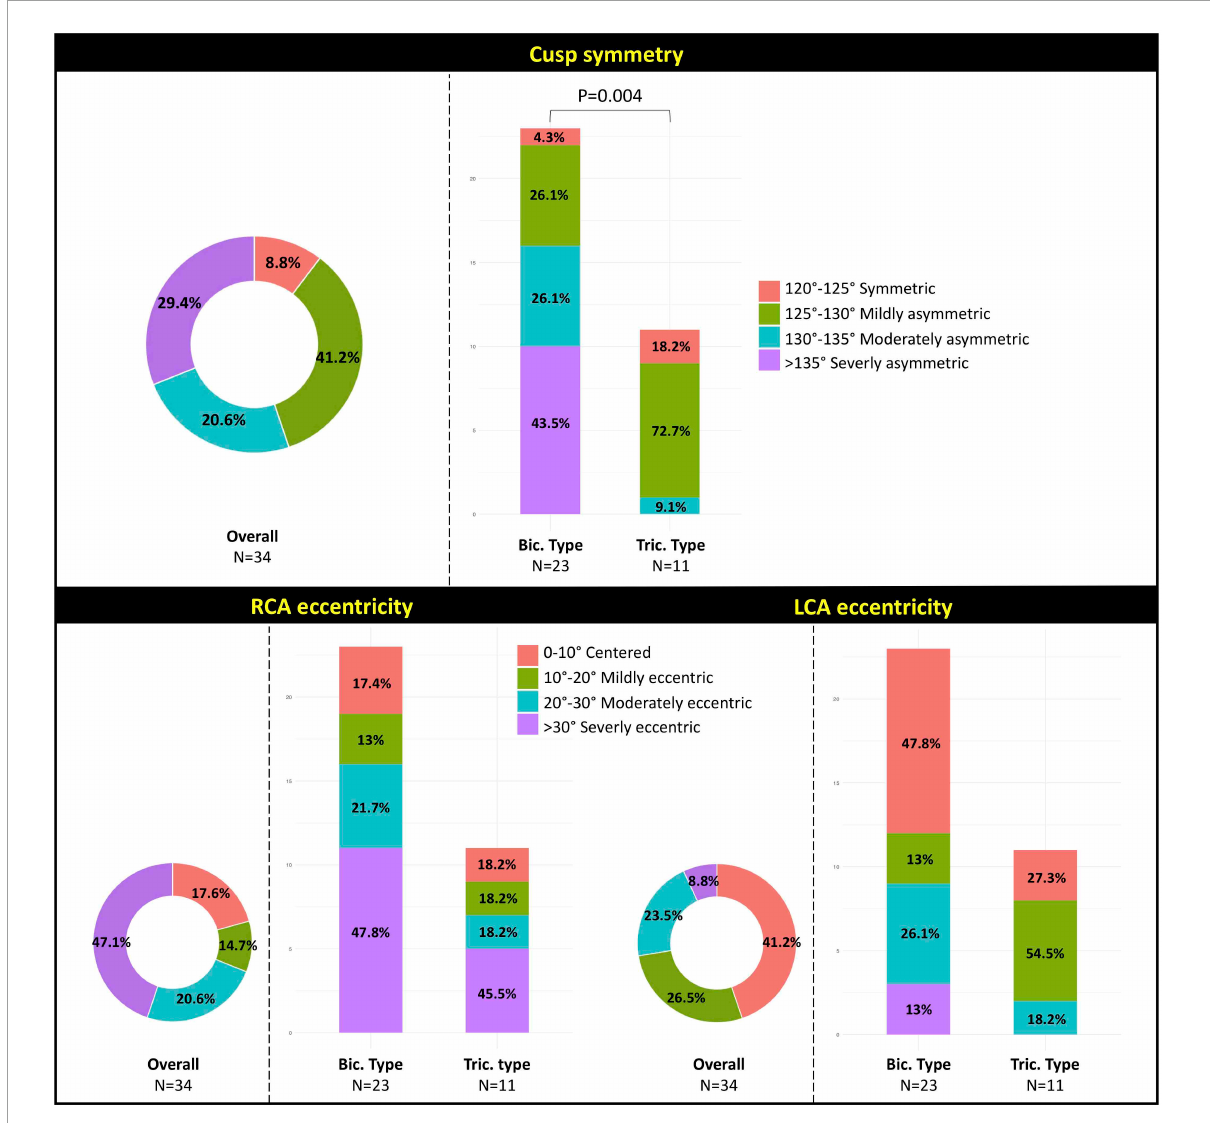
FIGURE3 Illustration of the degree of anatomical asymmetry in study’s BAV population: (top panel) cusp symmetry; (bottom panel) coronary ostia eccentricity. BAV, bicuspid aortic valve; RCA, right coronary artery; LCA, left coronary artery; Bic., bicommissural; Tric.,